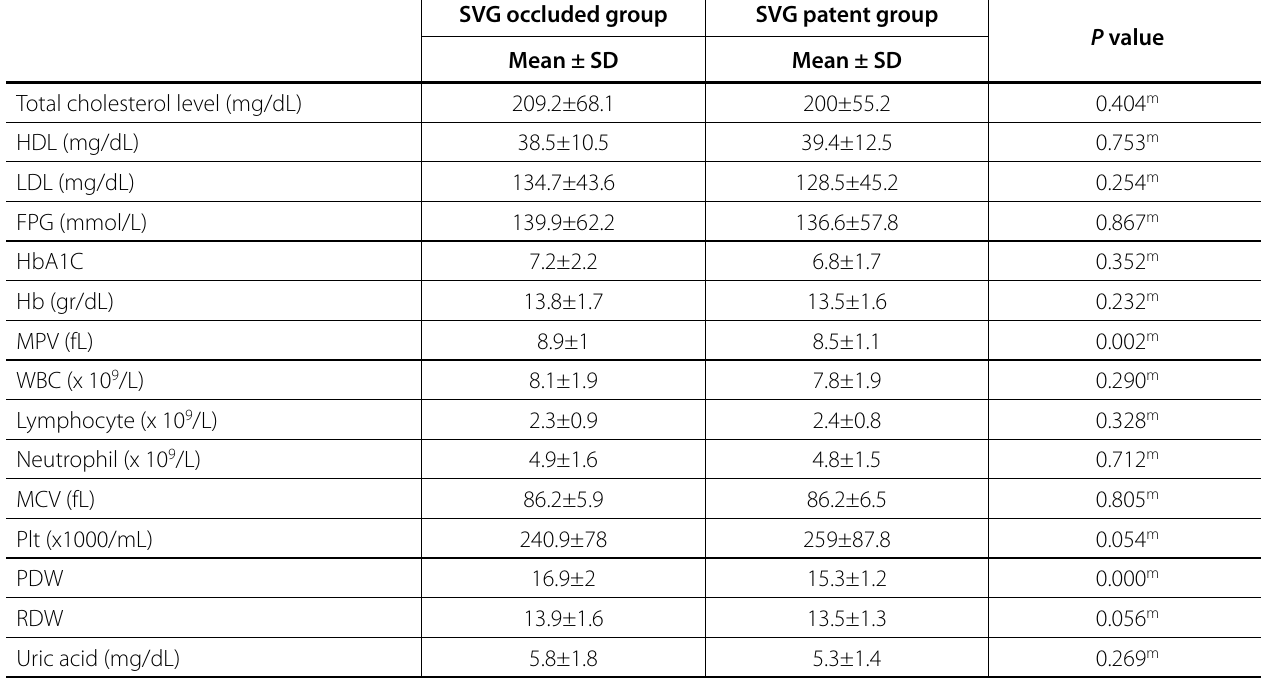
Table 2 . Blood test results before the CT coronary angiogram.